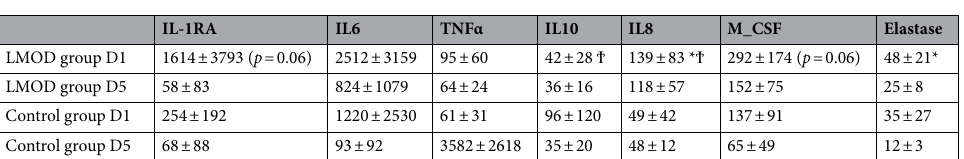
Table 3. cytokine’s measurement. * p < 0.05 LMOD group D1 vs D5 Friedman test. |p < 0.05 control group D1 vs D5. Ϯ p < 0.05 LMOD group D1 vs control group